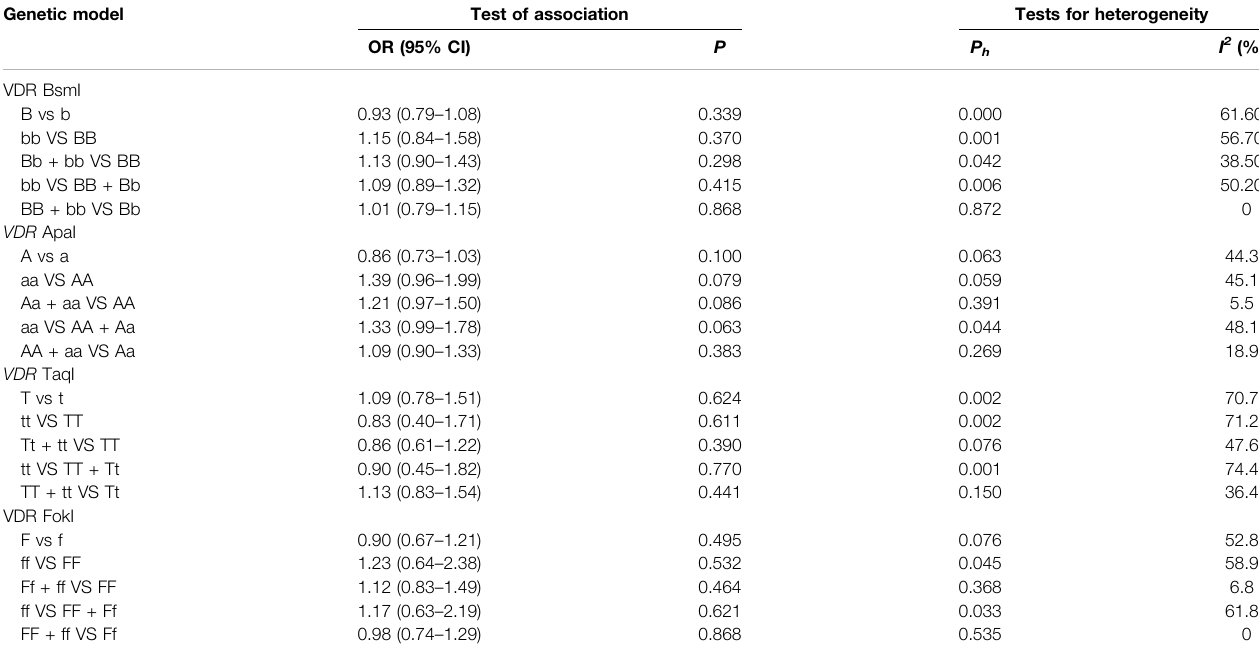
TABLE13| PooledestimatesofassociationofVDRBsmI,ApaI,TaqI,andFokIpolymorphismsandtheriskofosteoporoticfracture,excludinglow-qualityandHWDstudies. Genetic